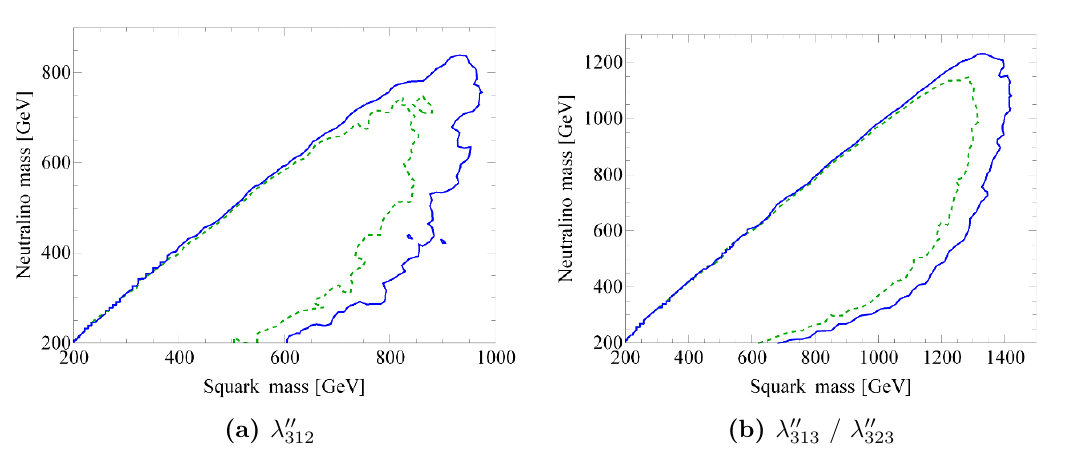
Figure 14. Exclusion curves within the neutralino-squark mass parameter space for a bino neu- tralino. Figure (a) presents (cid:21) 00 green curves assume leading order squark production whereas the solid blue curves include MSSM